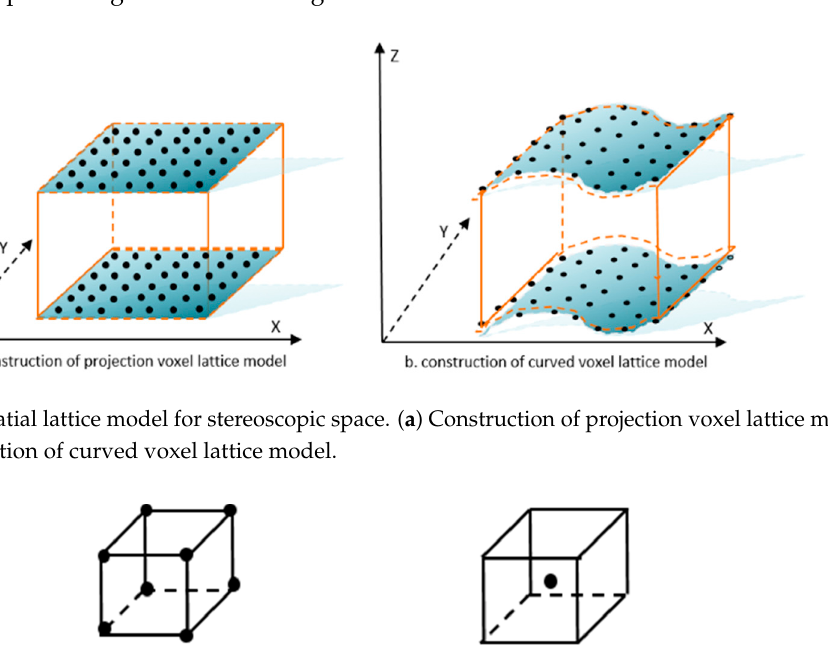
Figure 5. Spatial lattice model for curved surface space.